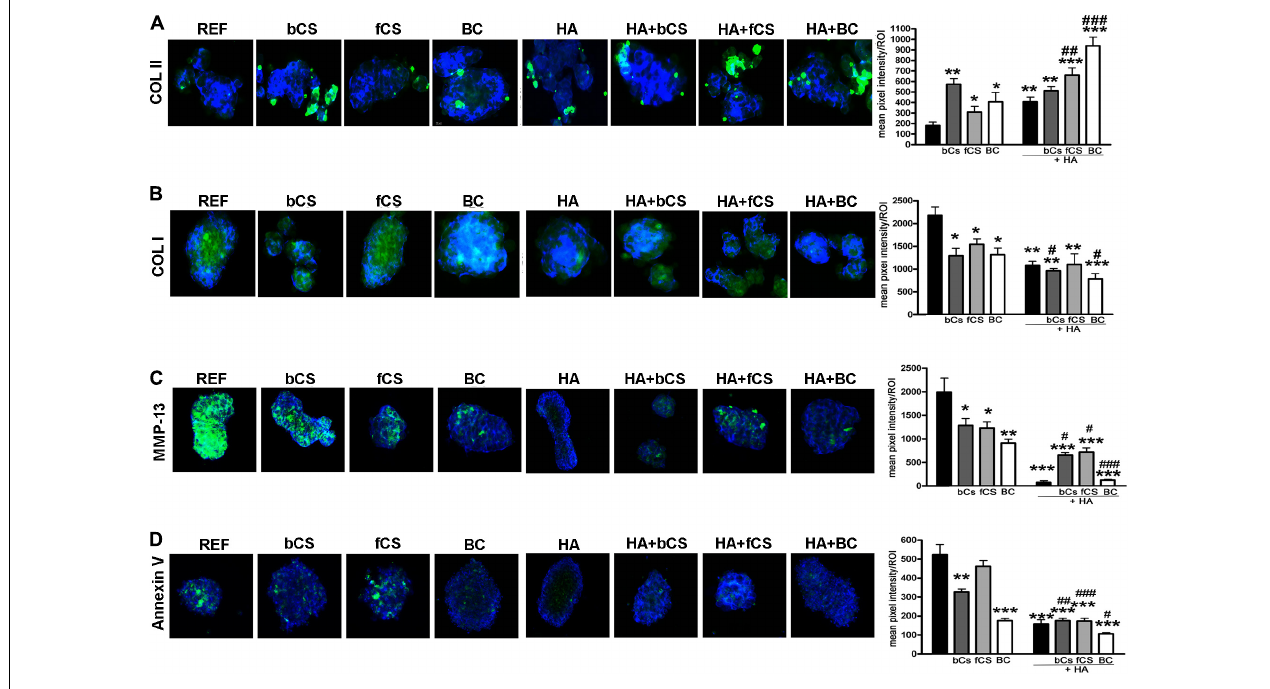
FIGURE 4 | Immunohistochemistry on differentiated MSCs. (A–C) Representative images of Type II collagen (A) , Type I collagen (B) , and MMP13 (C) immunostaining (green) on pellets treated as designated in the figure. Nuclei were counterstained with DAPI (blue). Graphs show the mean pixel intensity of green staining. The staining was quantified using Quantity One 1-D analysis software (Bio-Rad, CA, United States). Data are expressed as ROI (region of interest) units with standard deviation ( n = 3, * < 0.05; ** < 0.01; *** < 0.001; # < 0.05; ## < 0.01; ### < 0.001). The symbol * indicates the significance between reference differentiation and all the other experimental conditions. The symbol # indicates significance between each hydrogel with chondroitin only and the corresponding hydrogel with chondroitin plus HA (–) stands for no chondroitin supplementation. (D) Representative image of apoptosis detection by annexing staining (green) on pellets treated as designated in the figure. Nuclei were counterstained with DAPI (blue). Graphs show the mean pixel intensity of green staining. Data are expressed with standard deviation ( n = 3, * < 0.05; ** < 0.01; *** < 0.001; # < 0.05; ## < 0.01; ### < 0.001). The symbol * indicates the significance between reference differentiation and all the other experimental conditions. The symbol # indicates significance between each hydrogel with chondroitin only and the corresponding hydrogel with chondroitin plus HA. NG stands for No GAG